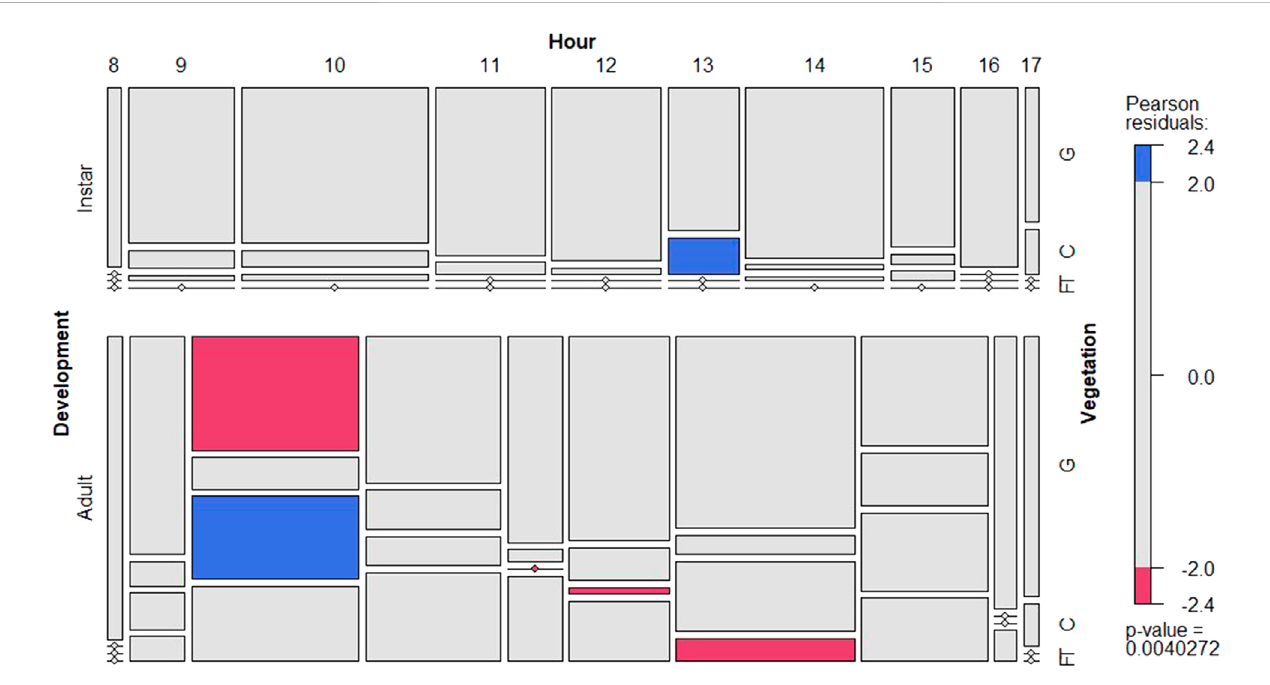
FIGURE 3 Conditionalmosaicplotbasedonthecontingencytablewiththenumberoflocustrecordsforallinstars(left fi gure)andadults(right)indaytime.Foreach development group it shows the departure from expectations per vegetation position (y-axis) and hour (x-axis). See details in Figure 2.